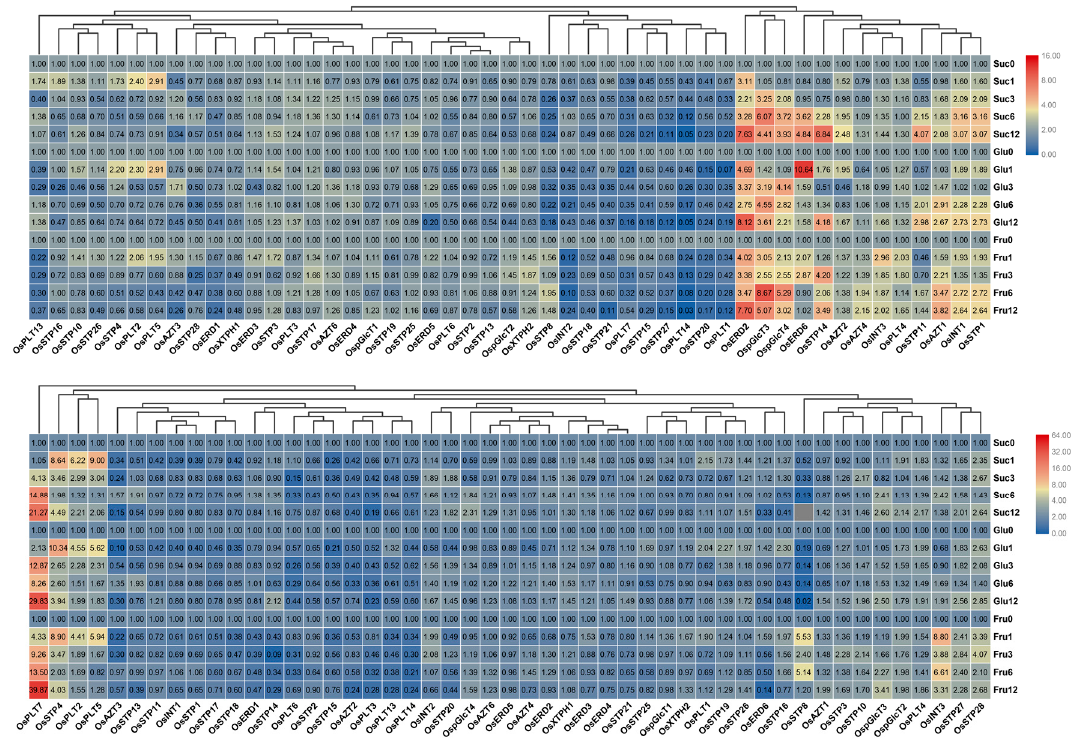
Figure 8. Expression changes of the MST genes in leaf ( A ) and root ( B ) under sucrose, glucose, and fructose treatments by qRT-PCR. 0, 1, 3, 6, 12 represents 0 h, 1 h, 3 h, 6 h, and 12 h after hormone treatment. The fold values were calculated by the 2 − ∆∆ CT method. The heat map was made based on the fold values. The color scale at the right of each small image represents fold values: red indicates high up-regulation and green represents low up-regulation.